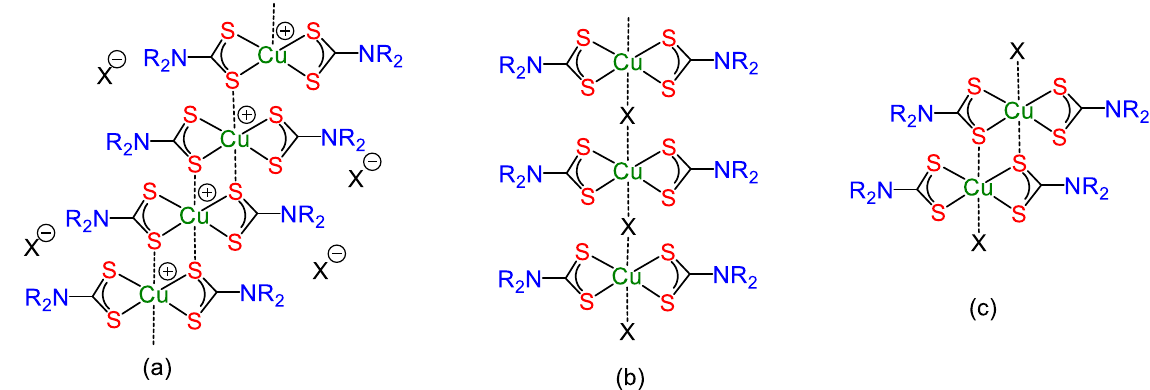
Figure 9. Line drawings of structural motifs ( a ) – ( c ) adopted by Cu(III) bis(dithiocarbamate) complexes.